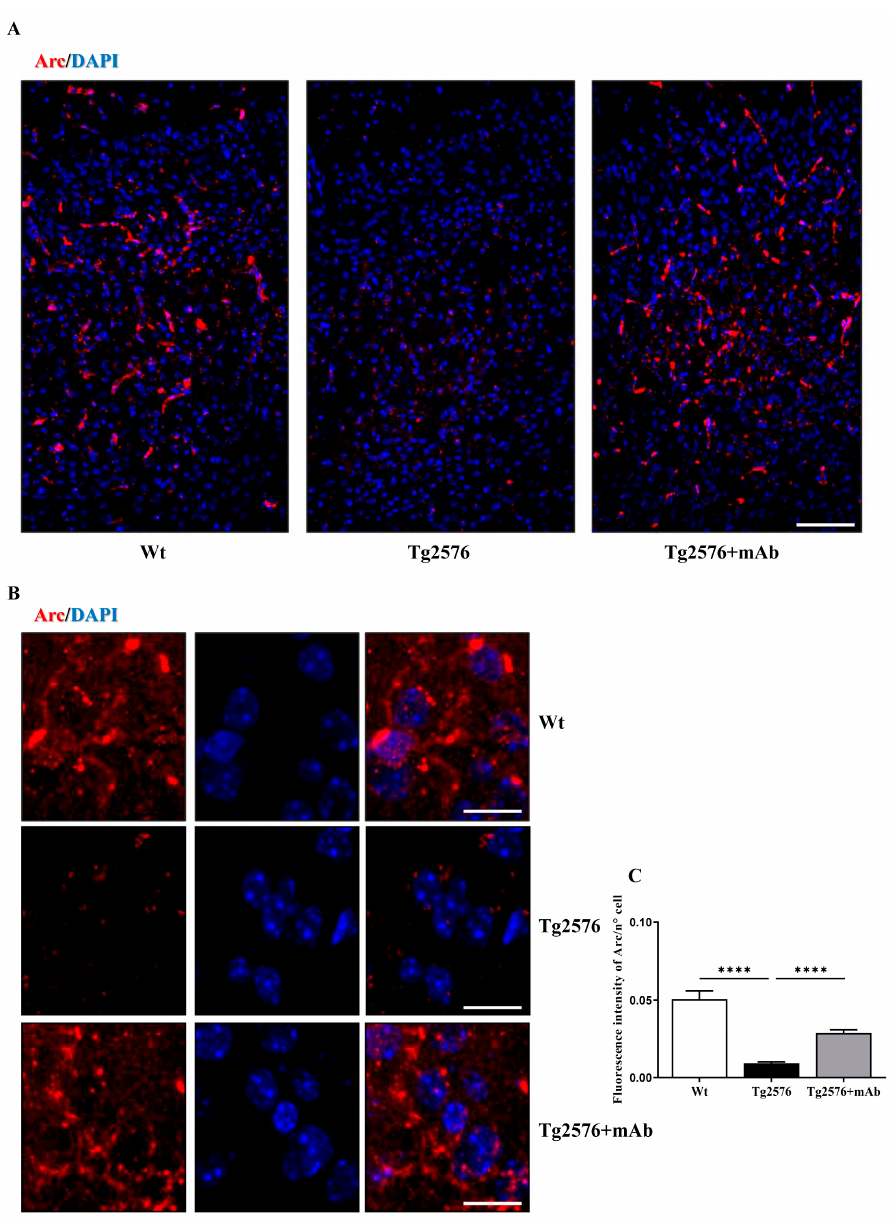
Figure 4. Impaired Arc/Arg3.1 protein expression in the V1 area in response to visual stimulation of Tg2576 AD mice is rescued by 12A12mAb administration . ( A , B ) Immunohistochemical